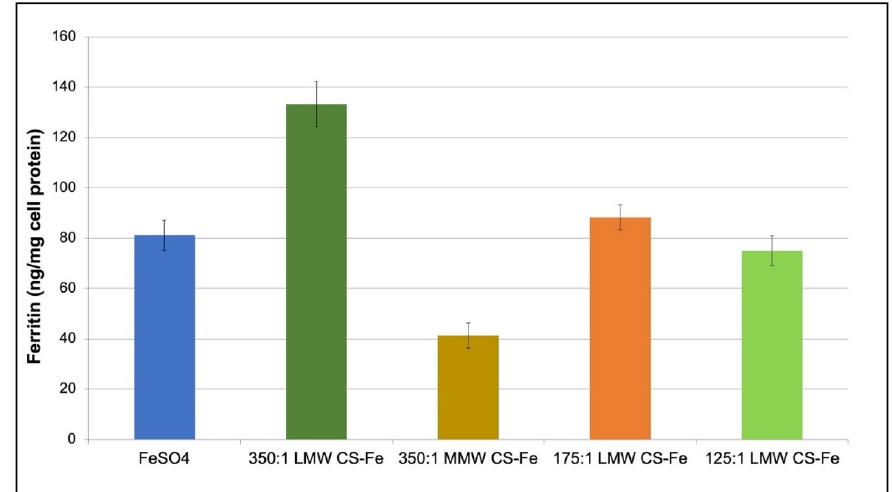
Figure 10. Iron absorption by Caco-2 cells incubated with WPI-CS-Fe nanoparticle preparations.